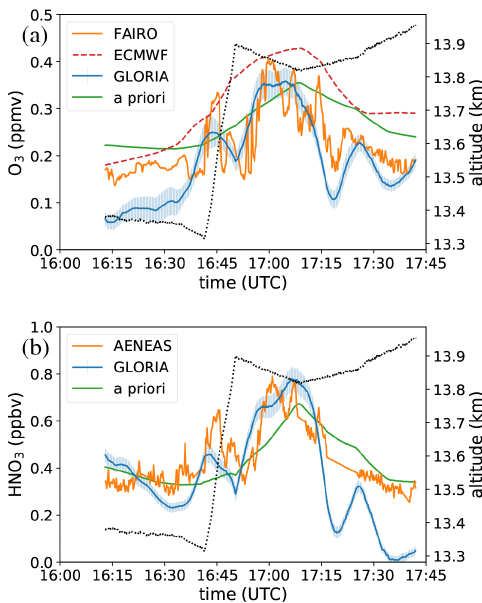
Figure C1. Comparison to in situ instrument data along the flight path. A priori data are from the WACCM model. Refer to the main text regarding details on in situ instruments and